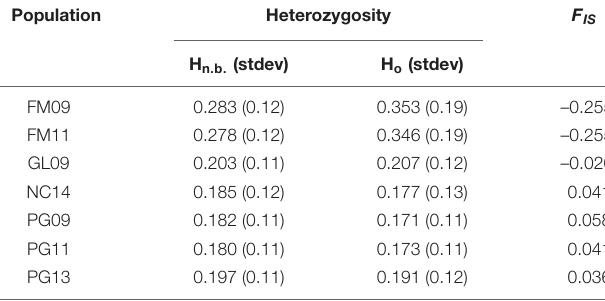
TABLE 2 | Population genetic diversity